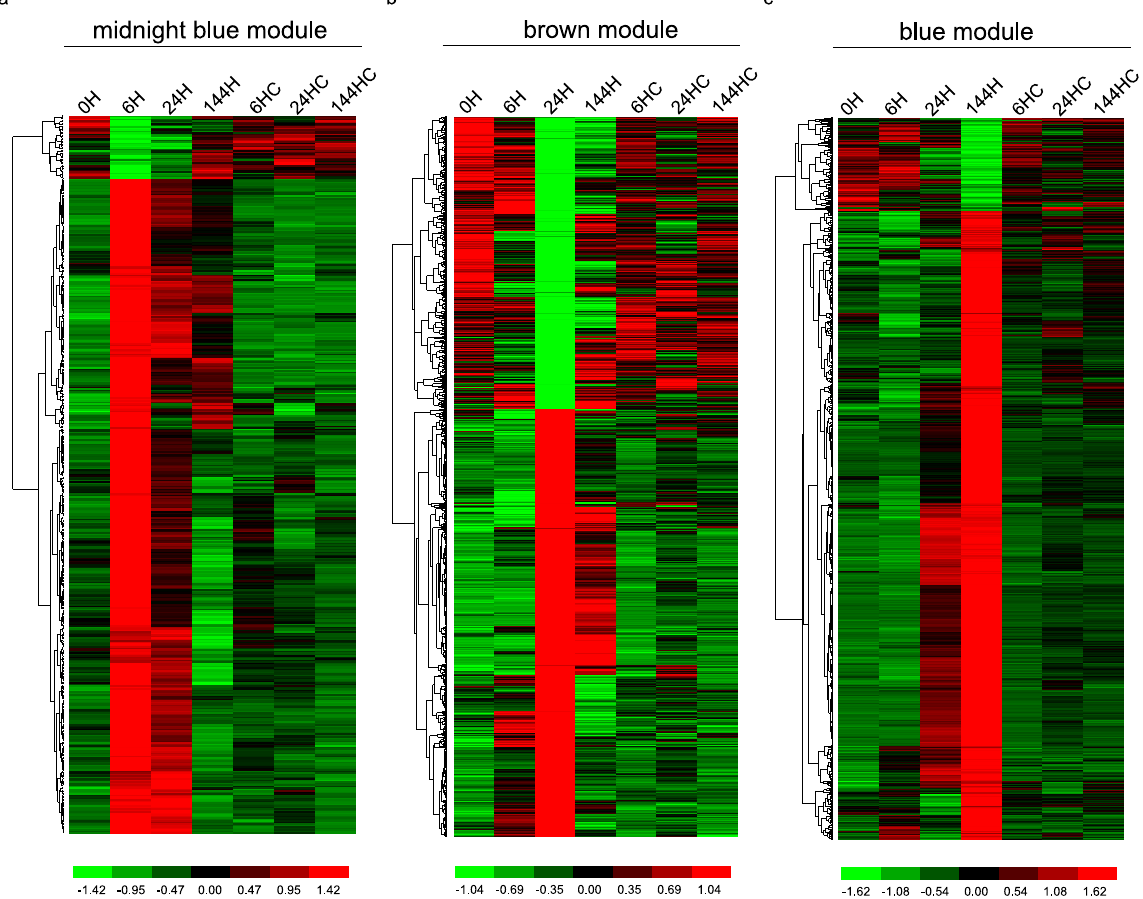
Figure 4. Heat maps showing the expression patterns of modules from the light-responsive genes.